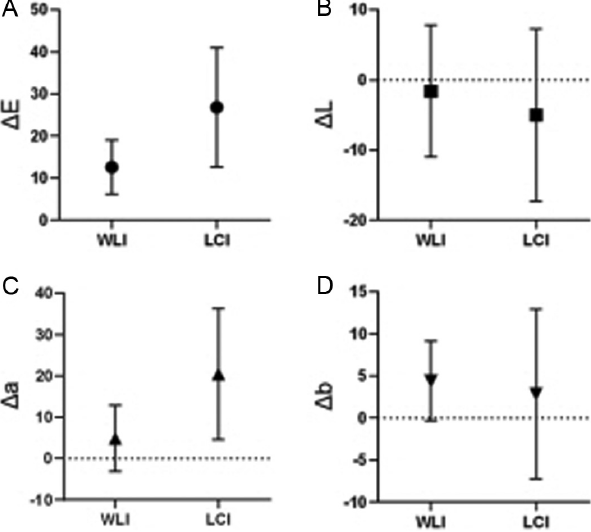
Figure 3. Color differences between cancerous lesions and the surrounding mucosa with white light imaging and linked color imaging.